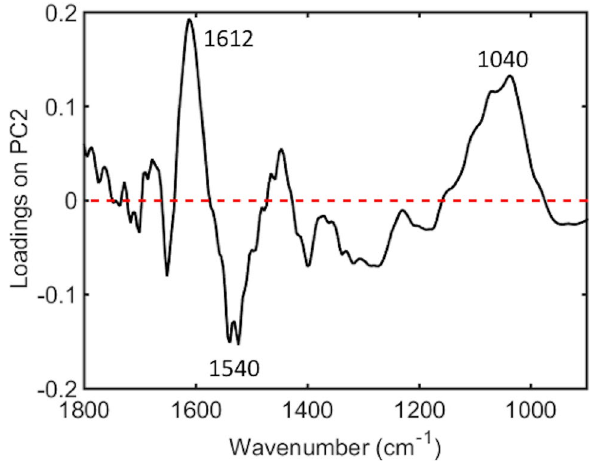
Figure 3. Main band differences for healthy controls (HC) vs. active disease (AD) using PCA loadings on PC2 from plasma samples—1612 cm −1 (higher in AD, adenine vibration in DNA), 1540 cm −1 (higher in HC, protein